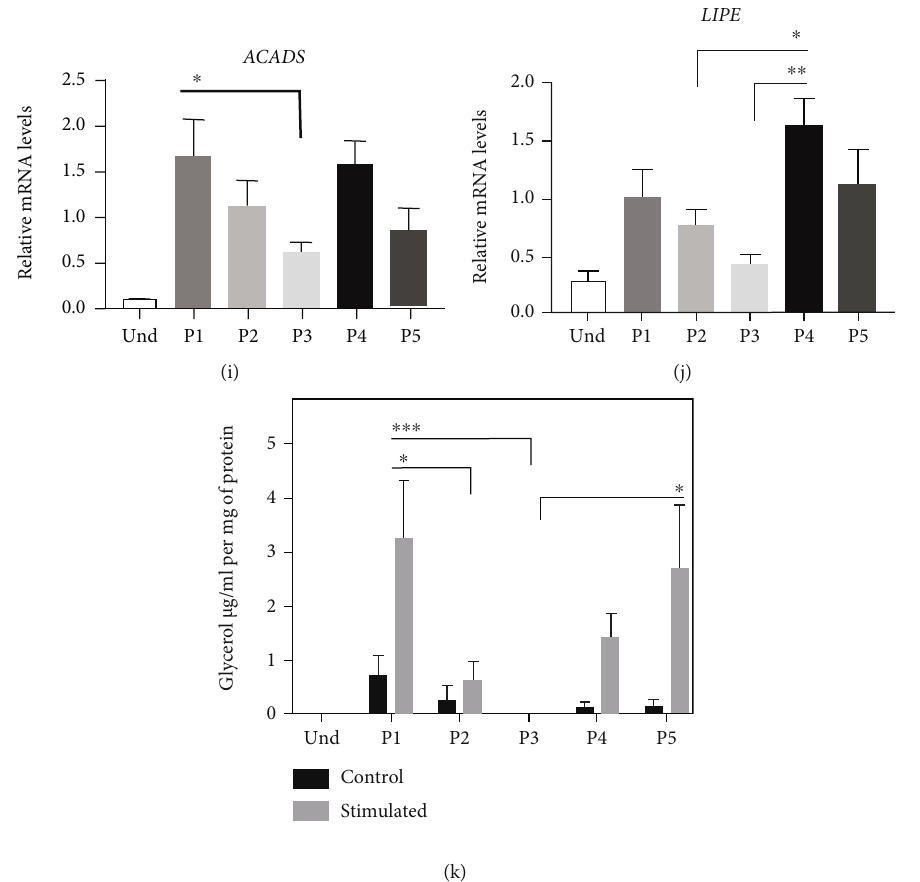
Figure 3: E ff ect of the di ff erentiation protocols on white and brown adipocyte markers and lipid metabolism gene expression. Human adipose-derived stem cells were di ff erentiated for 21 days with fi ve adipogenic di ff erentiation protocols. Relative mRNA expression of genes (a) CIDEA , (b) LEPTIN , (d) UCP1 , and (e) UCP2 measured by RT-qPCR. (c) Secretion of leptin to the cell culture media. (f) Protein levels of UCP1 and vinculin were analyzed by western blotting and quanti fi cation of UCP1 level relative to vinculin. (g) Relative mRNA expression of UCP1 in in vitro -di ff erentiated adipocytes, white adipose tissue (WAT), and mature adipocyte fraction (MAF) of the same subjects measured by RT-qPCR. Relative mRNA expression of genes (h) ACADM , (i) ACADS , and (j) LIPE measured by RT- qPCR. Gene expression results were normalized to the expression of reference genes IPO8 and GUSB using qBASE software. (k) Basal and isoproterenol-stimulated free glycerol release in media. Statistical analysis was performed using one-way ANOVA followed by Tukey ’ s post hoc analysis ( n = 6 ): ∗ p < 0 : 05 , ∗∗ p < 0 : 01 , and ∗∗∗ p < 0 : 001 . Error bars are shown as SEM. The statistical di ff erences in (a), (e), and (f) indicate a comparison with all the other